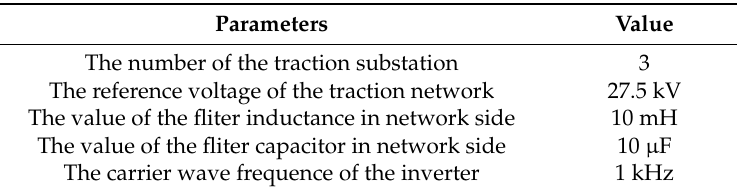
Table 6. The parameters of